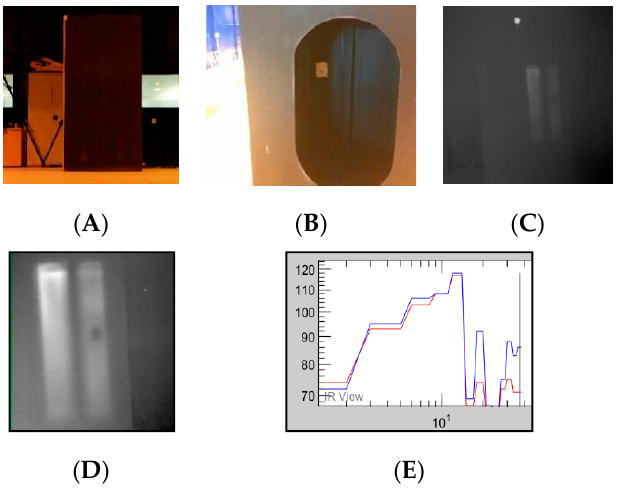
Figure 25. ( A ) Red/green/blue (RGB) image of the composite wing. ( B ) Rear image of the wing displaying the debris inside. ( C )IR image taken of the composite wing using the Zenmuse XT camera. ( D ) Debris prompted a contrast difference in the thermal data. ( E ) Temperature/time graph. The images where taken at different locations. Interference and instability resulted in corrupted data.